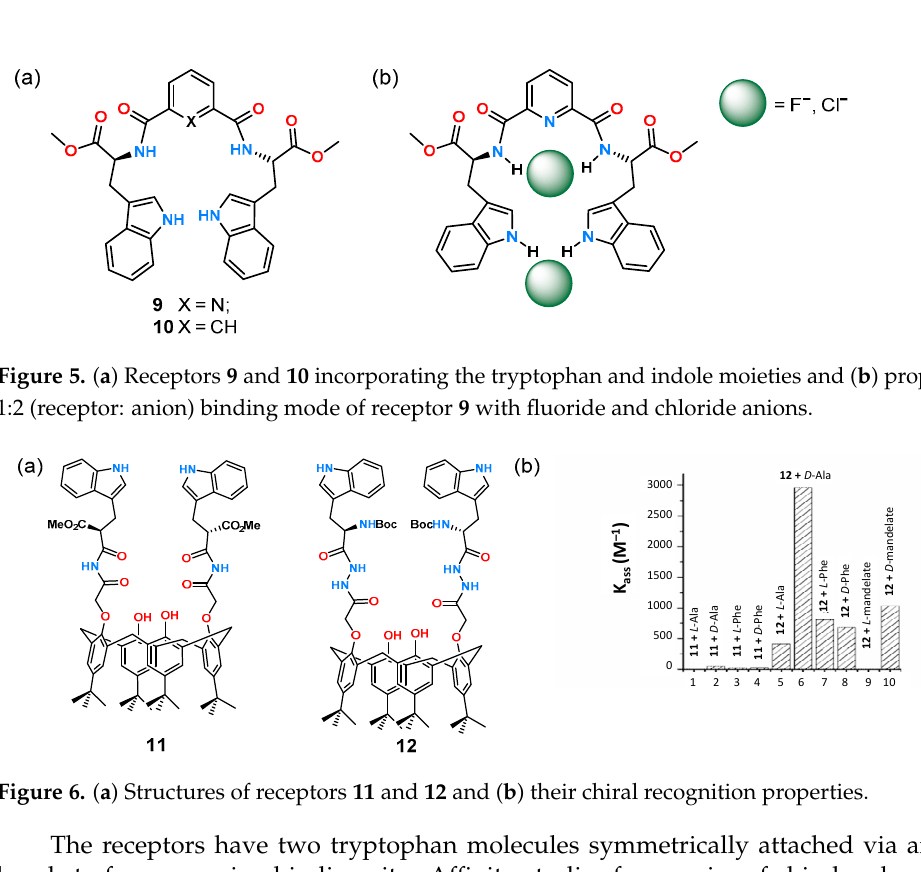
Figure 5. ( a ) Receptors 9 and 10 incorporating the tryptophan and indole moieties and ( b ) pro- posed 1:2 (receptor: anion) binding mode of receptor 9 with fluoride and chloride anions. While the isophthalic derivative 10 practically did not interact with the tested anions, receptor 9 formed complexes with stoichiometry 1:2 with chloride and fluoride anions